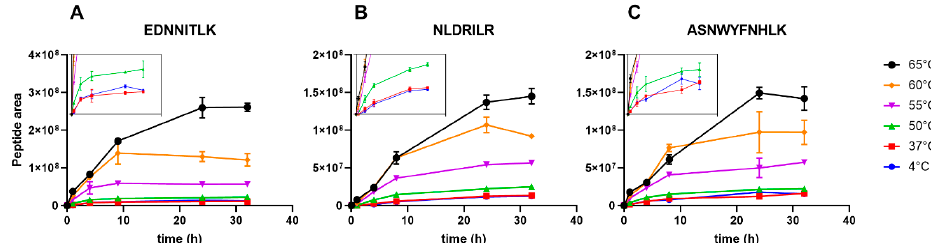
Figure 2. Formation of peptides ( A ) EDNNITLK, ( B ) NLDRILR, and ( C ) ASNWYFNHLK over time (2 (50, 55, 60, 65 ◦ C) or 30 days (37 ◦ C)). Peptides were quantified by label-free quantification. Insets: zoomed graphs show the di ff erences between exposure to 4 and 37 ◦ C, and 50 ◦ C. Error bars represent SD of three